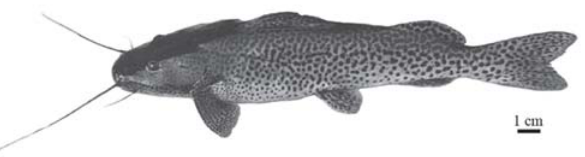
Fig. 1. Steindachneridion parahybae , Paraíba do Sul River basin, Paraibuna, São Paulo State, Brazil. Lateral view (image by Caneppele).